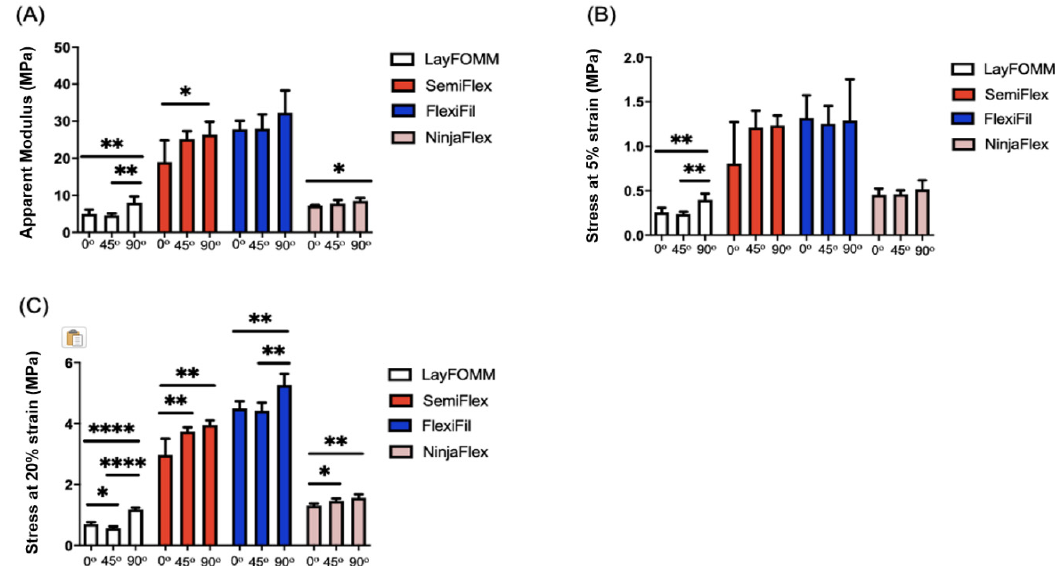
Figure 5. Mechanical properties of the Lay FOMM 60, SemiFlex, FlexiFil, and NinjaFlex materials for three raster angles: 0 ◦ , 45 ◦ , and 90 ◦ . The mechanical properties displayed are: ( A ) apparent modulus; ( B ) stress at 5% strain; ( C ) stress at 20% strain. * p < 0.05, ** p < 0.01, **** p < 0.0001. Data shown represent the mean ± SD. Table 4. Results of one-way ANOVA comparing effects of raster angle on mechanical properties of flexible materials.